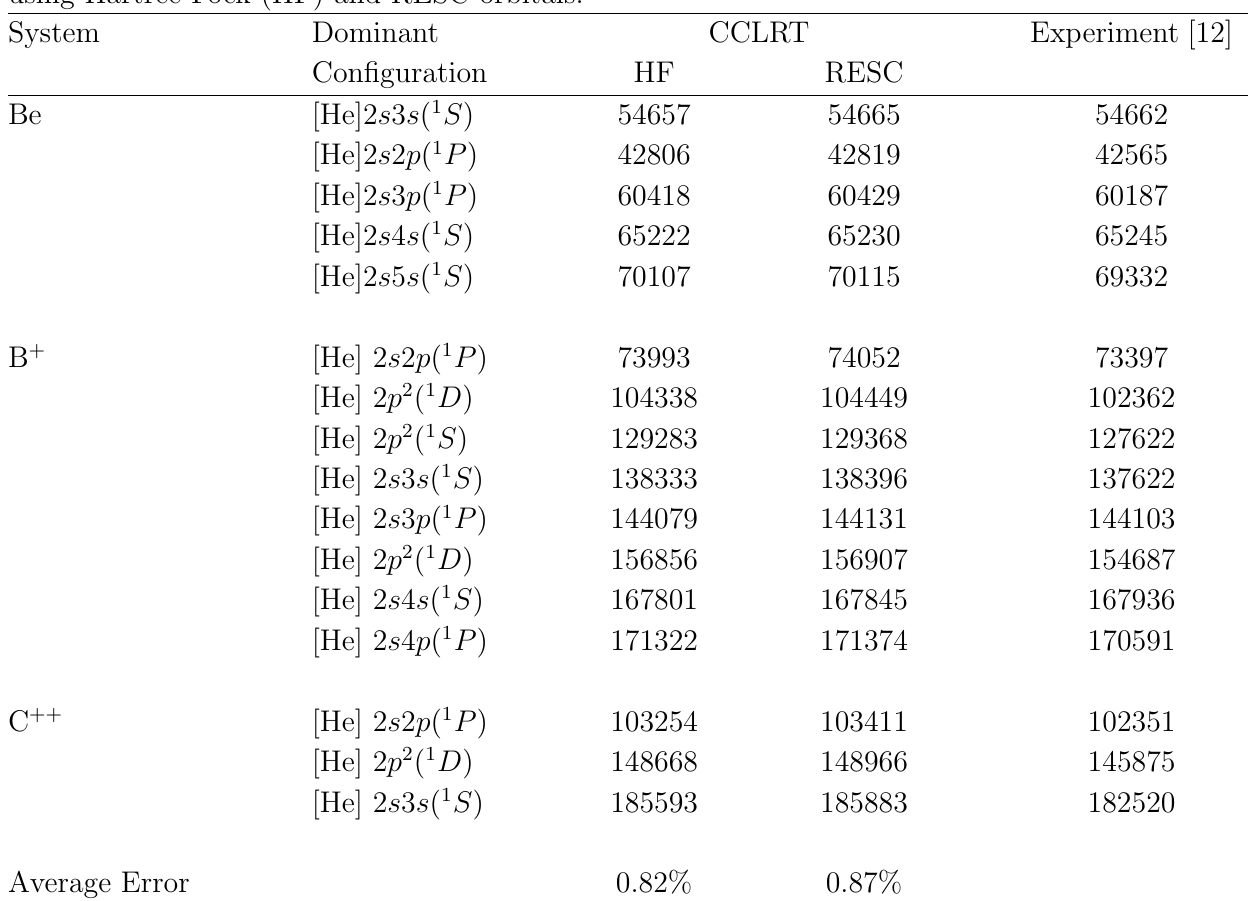
Table 4: Singlet state excitation energies (in cm − 1 ) of Be, B + and C ++ obtained from CCLRT-EE using Hartree-Fock (HF) and RESC